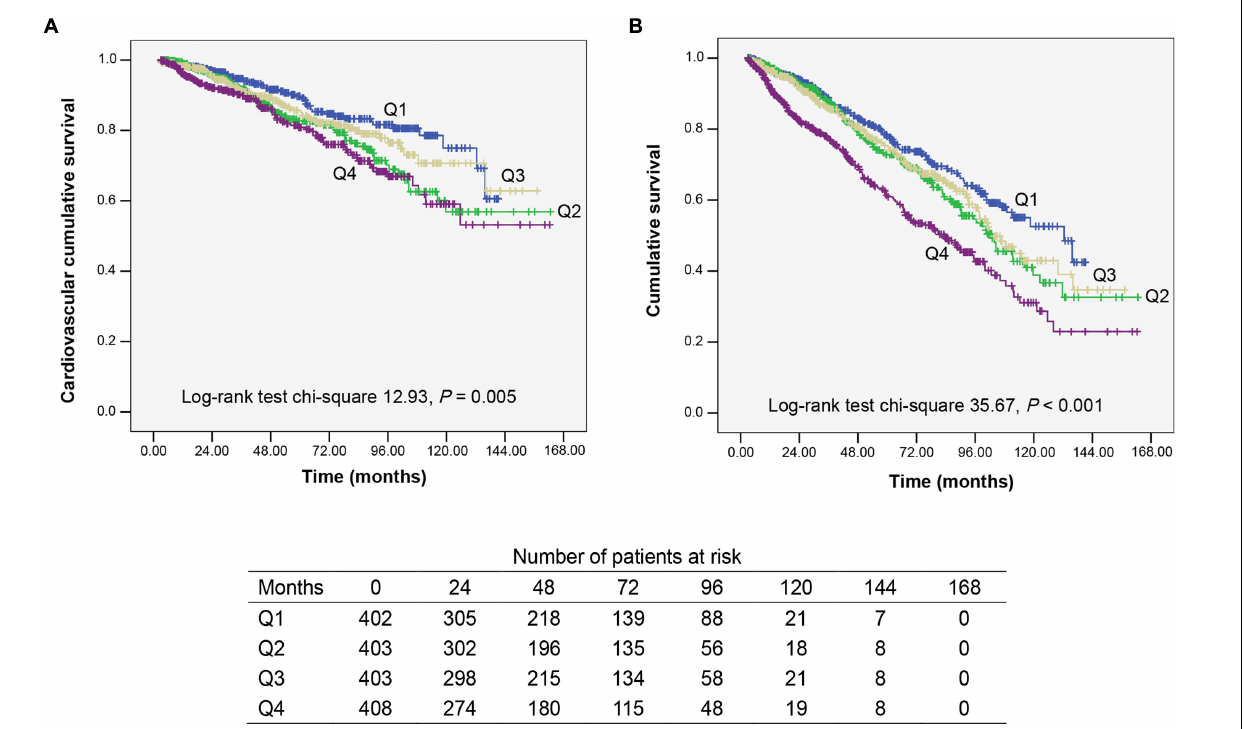
FIGURE 2 | Kaplan–Meier survival curves for participants categorized by apolipoprotein B (apo B)/apolipoprotein A1 (apo A1) ratio quartiles. (A) Cardiovascular mortality survival curves divided by apo B/apo A1 ratio quartiles. (B) All-cause mortality survival curves divided by apo B/apo A1 ratio quartiles. Q1–Q4, lowest to highest